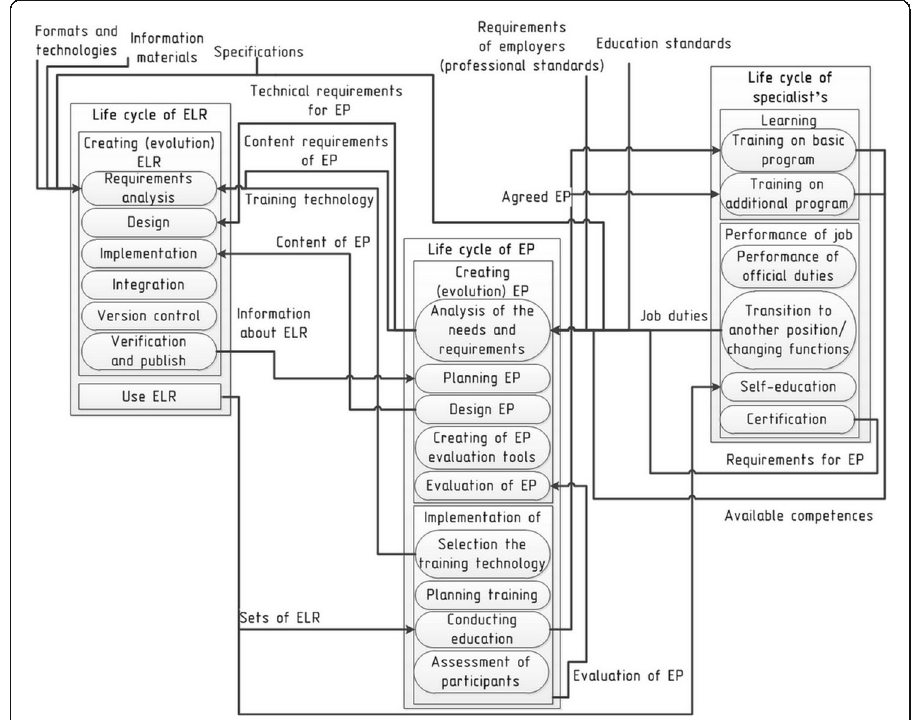
Fig. 3 The process of lifecycle ’ s synchronization for the learning environment